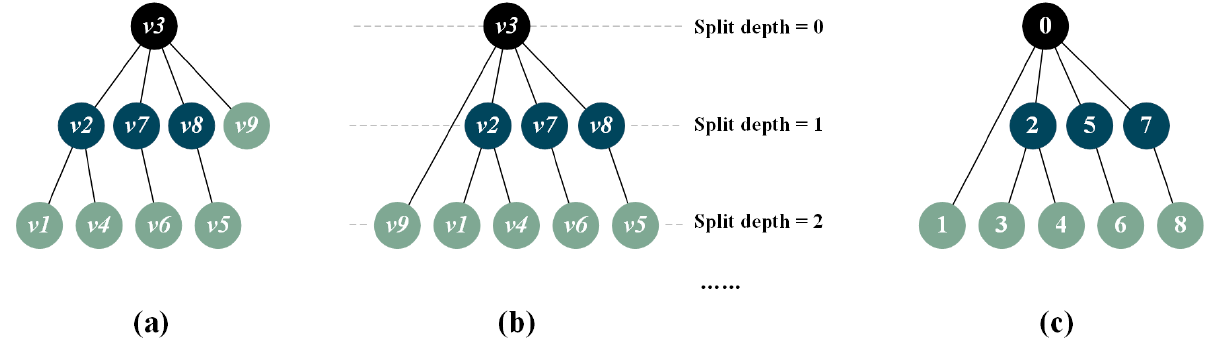
Figure 5. Construction of vertex tree: ( a ) The vertex tree obtained after multi-level vertex clustering; ( b ) the adjusted vertex tree after considering the split depth; ( c ) the vertex tree after